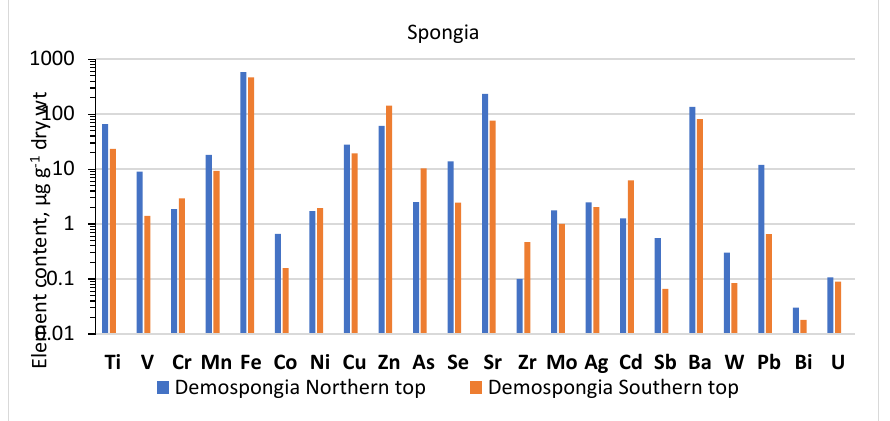
Figure 8. Distribution of elements in the Demospongia whole body’s specimens inhabited the northern and southern tops of the Piip Volcano.